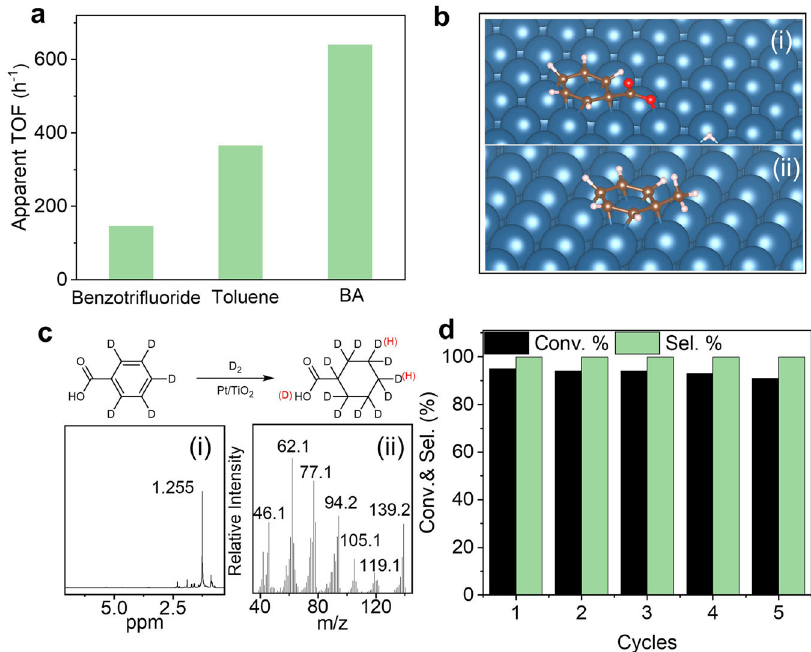
Fig. 4 Catalytic mechanism and stability test. a Comparison of the catalytic activity of Pt/TiO 2 in hydrogenation of benzotri fl uoride, toluene, and BA. b The adsorption mode of ( i ) BA and ( ii ) toluene on Pt (111). c 1 H-NMR ( i ) and MS analysis ( ii ) of the product for benzoic-d 5 acid hydrogenation with D 2 . d Recycling stability of Pt/TiO 2 in the hydrogenation of BA. BA benzoic acid, MS mass